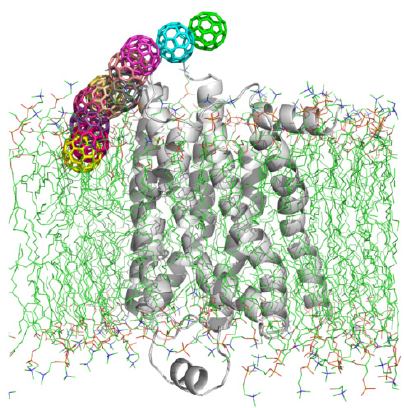
Figure 5. The traced positions of C 60 extracted from the snapshots of simulated trajectory of the C 60 _in1 system. The green and yellow models represent the initial and final positions, respectively.